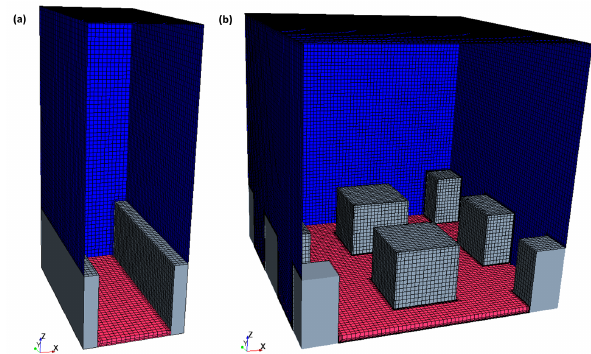
Figure 1. Illustration of the computational domains: (a) a single street canyon with H = 16m and W = 16m (2-D geometry), and (b) a staggered array of cubes with H , W and L equal to 16m (3-D